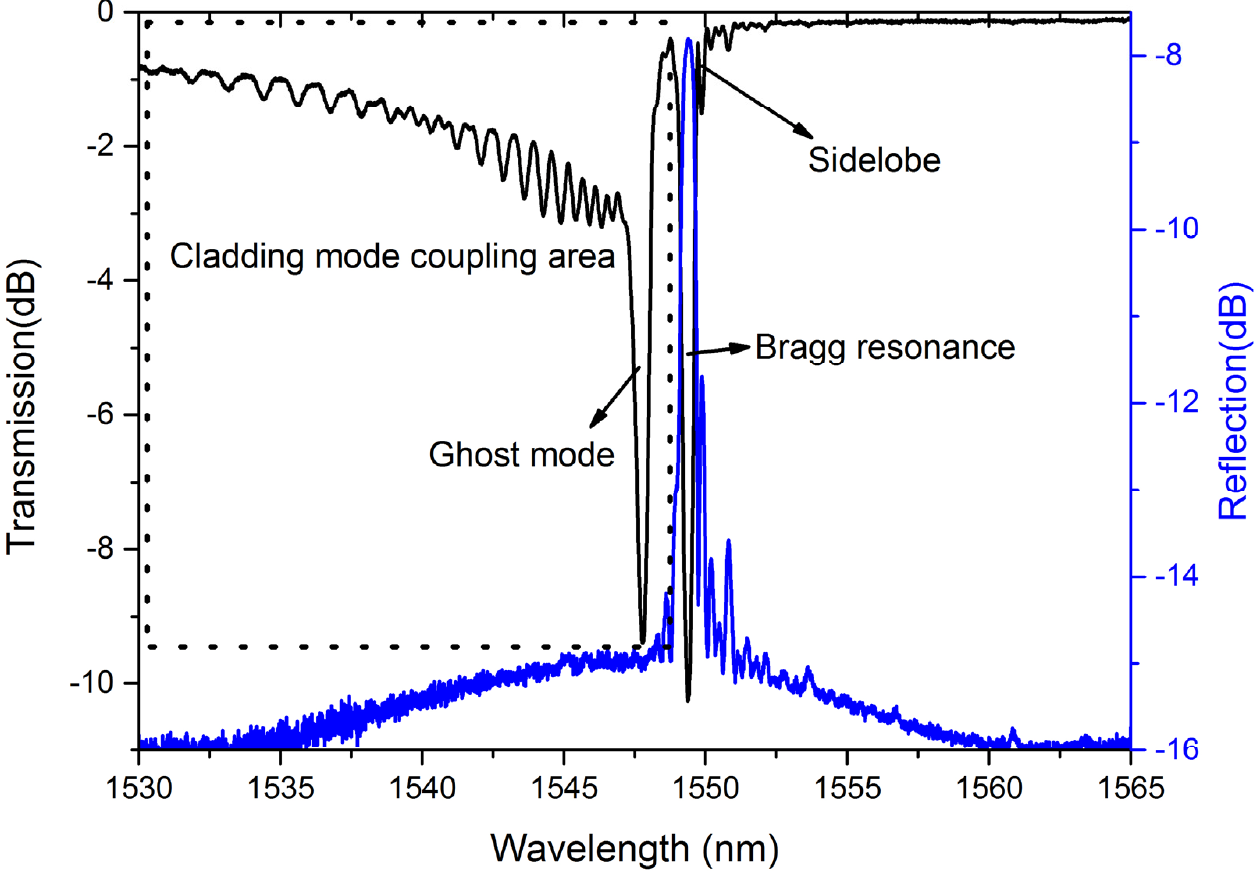
Figure 2. Typical spectrum of LBL-FBG (black-dotted-bordered rectangle represents the cladding mode coupling area).